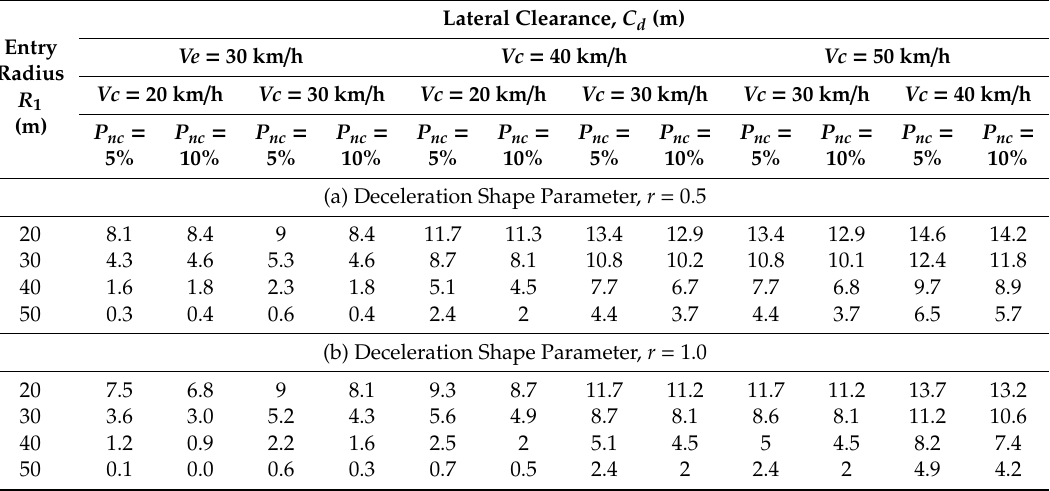
Table 6. Reliability-based maximum lateral clearance needs for the circulating vehicle for single-lane symmetrical roundabouts (approach vehicle at yield line) b .